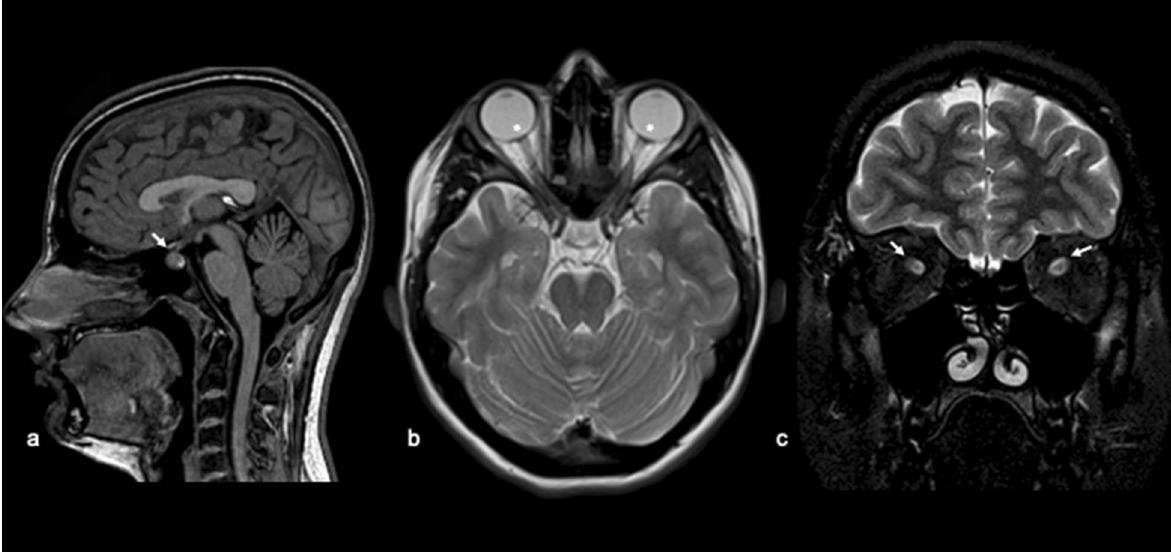
Fig. 2 MR of the same patient after external lumbar shunt placement, revealed in sagittal T1WI a a normal size pituitary gland with superior convexity (arrow), as expected to the age group; apparent completely resolution of the posterior eye globes flattening (asterisks) on axial T2WI ( b ) and return to normal size of the optic nerve/sheath complex without signs of transudation on the coronal T2WI FatSat (arrows) ( c